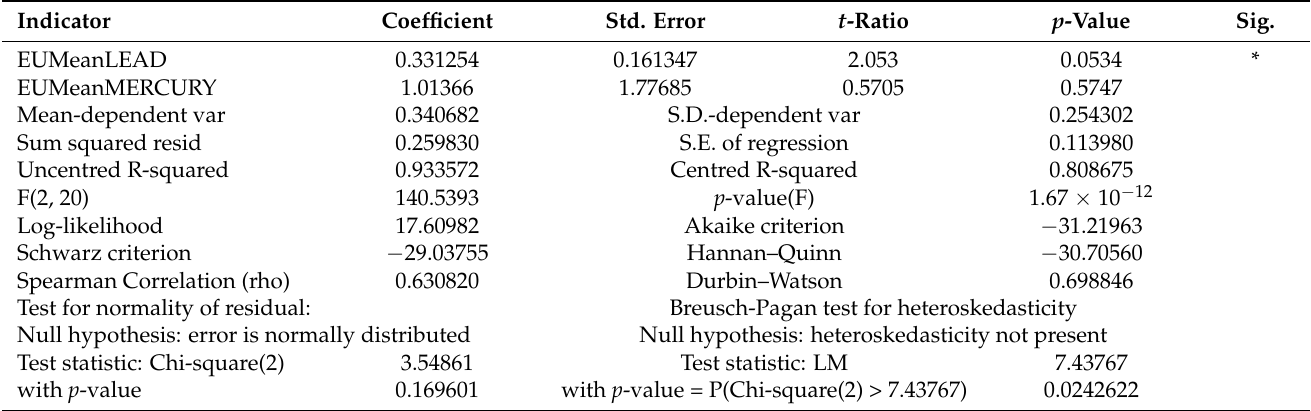
Table 3. European model for the management of heavy metal water pollution